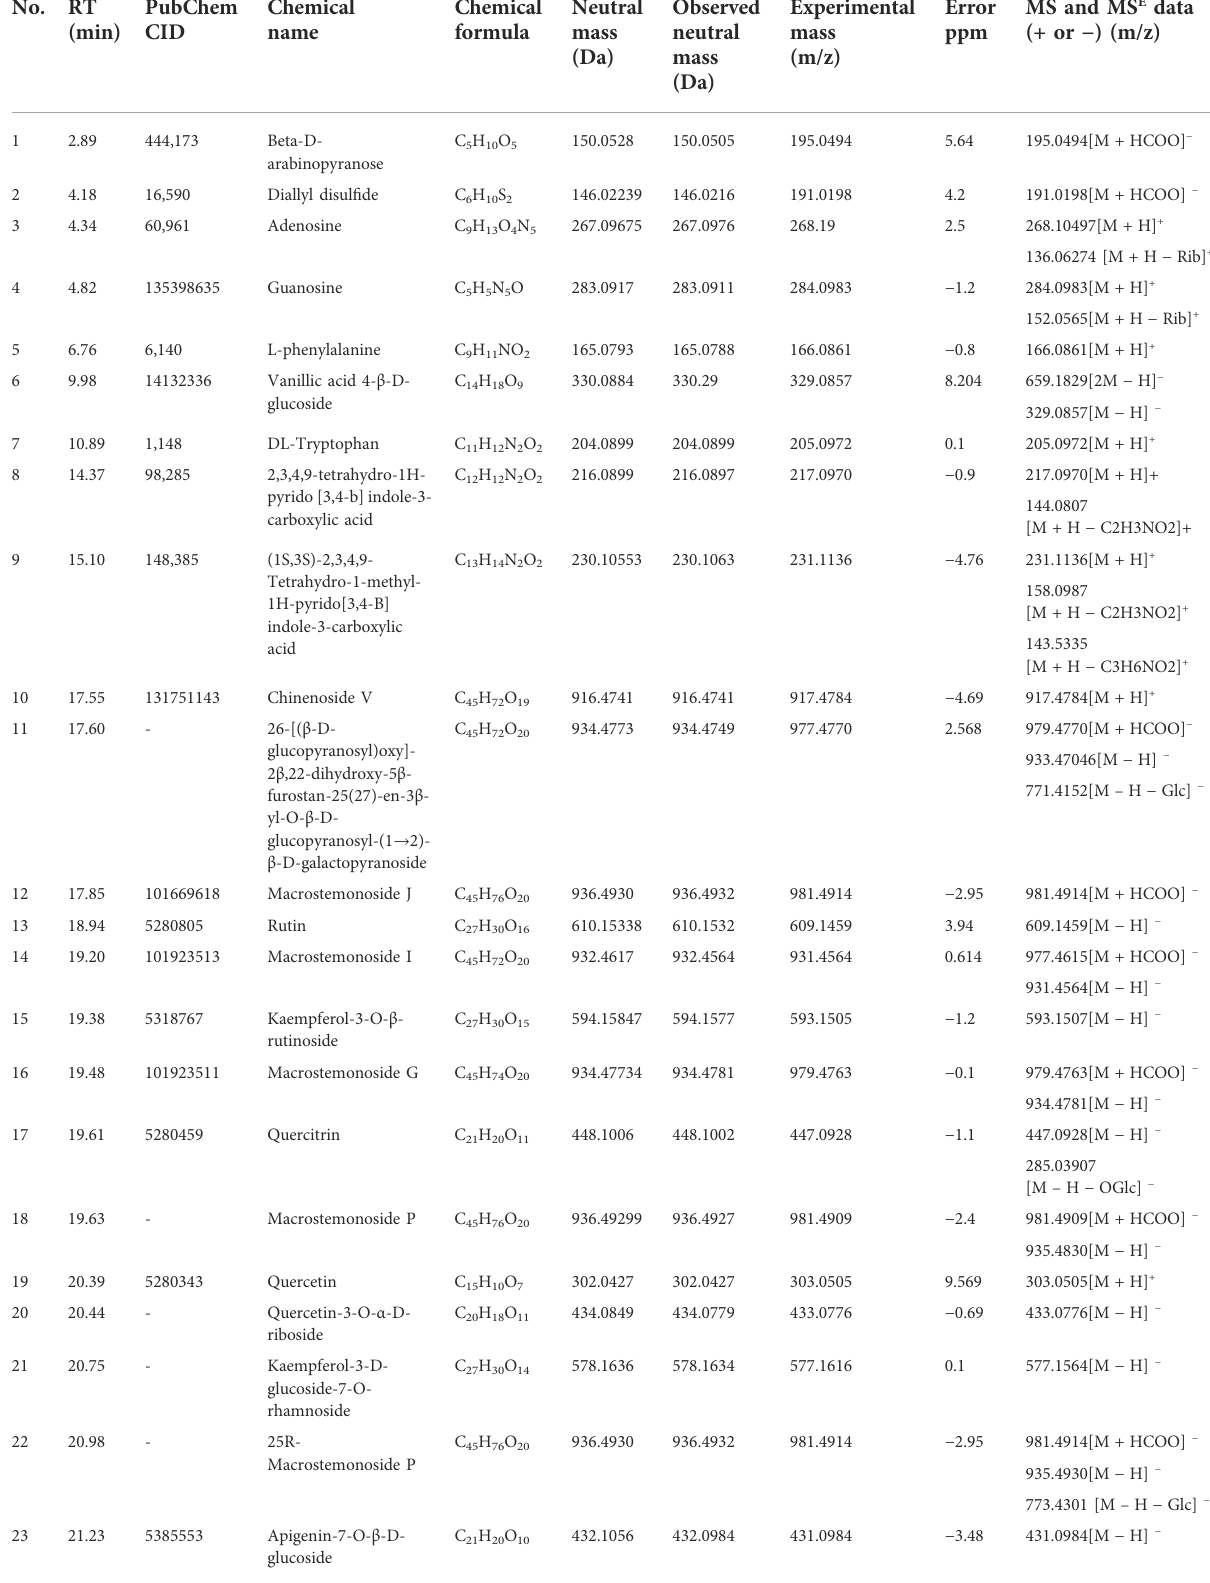
TABLE 1 Analysis of compounds of GLXB using HPLC-Q-TOF-MS E